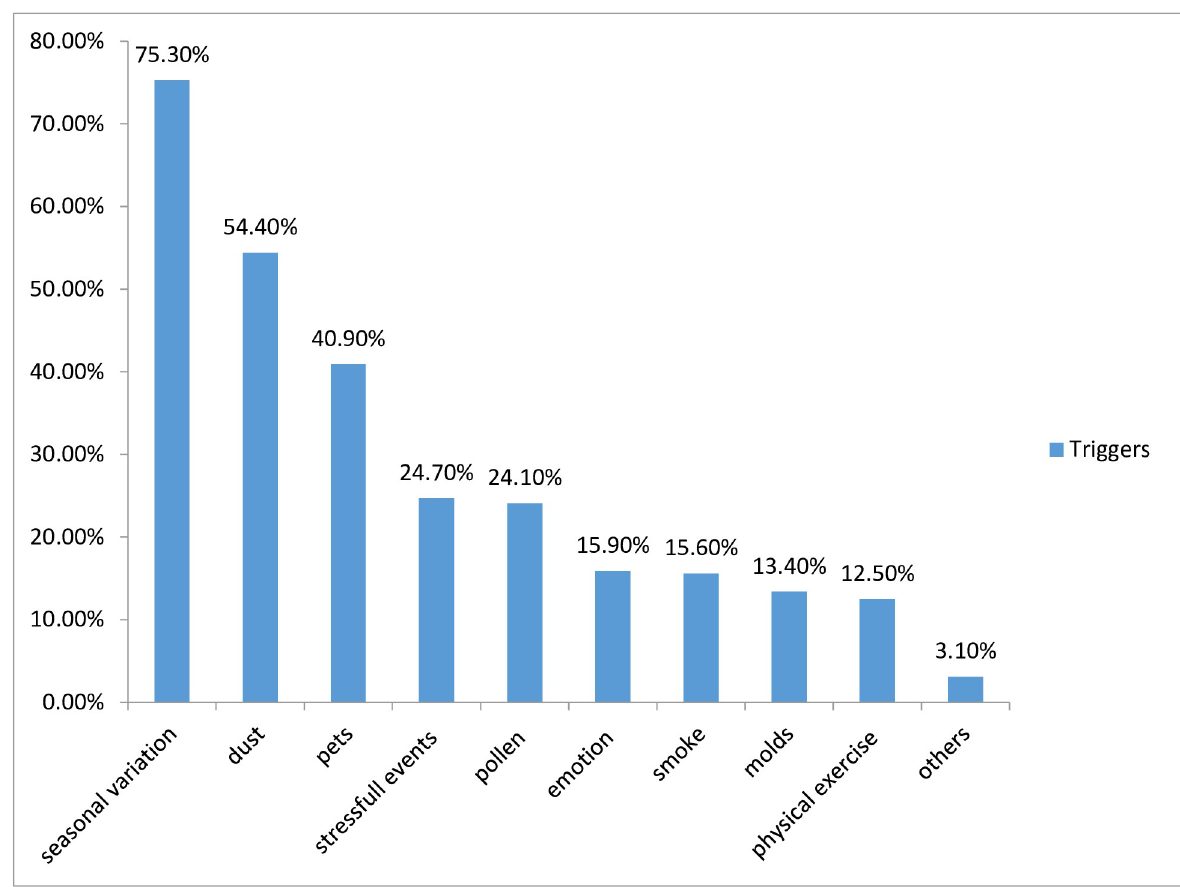
Fig 2. Triggering factors of asthma among study participants. Note; Others: perfume, aspirin, certain food, work related trigger (working in industry), and beta-blockers.